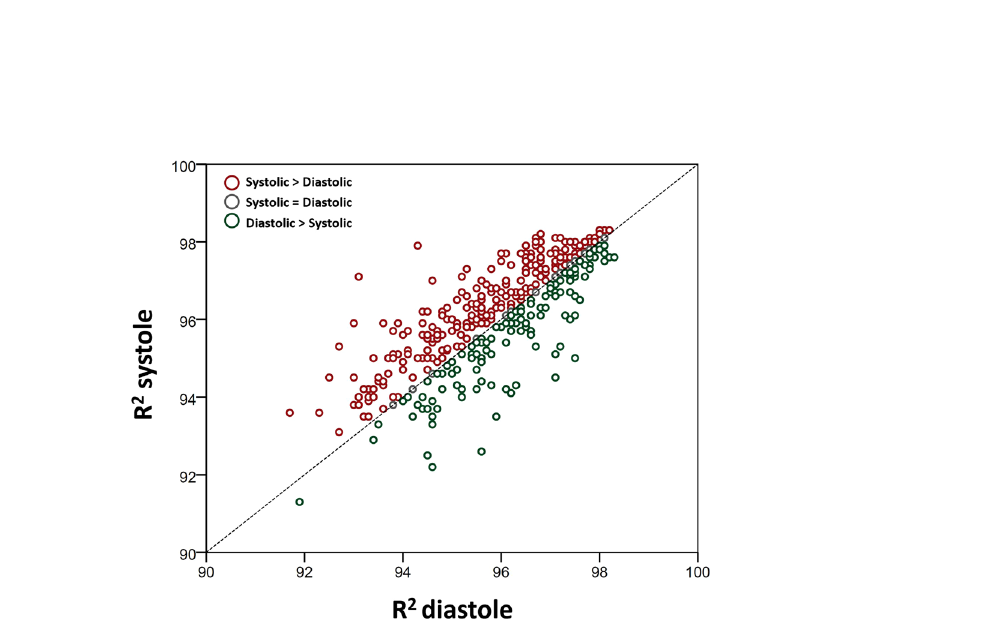
Figure 3. A graph of R 2 values plotted in diastole and systole, showing excellent correlation (r = 0.8) and low variability between the